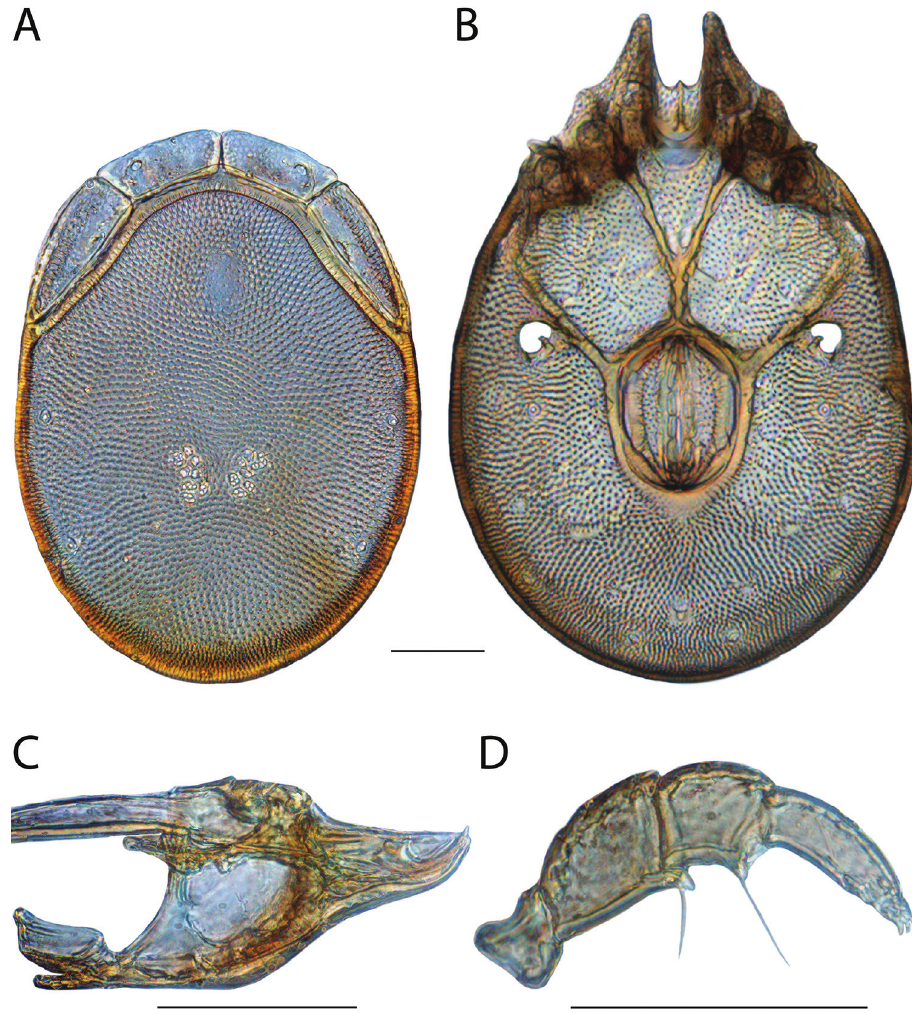
Figure 210. Torrenticola rala male: A dorsal plates B venter (legs removed) C subcapitulum D pedipalp (setae not accurately depicted). Scale = 100